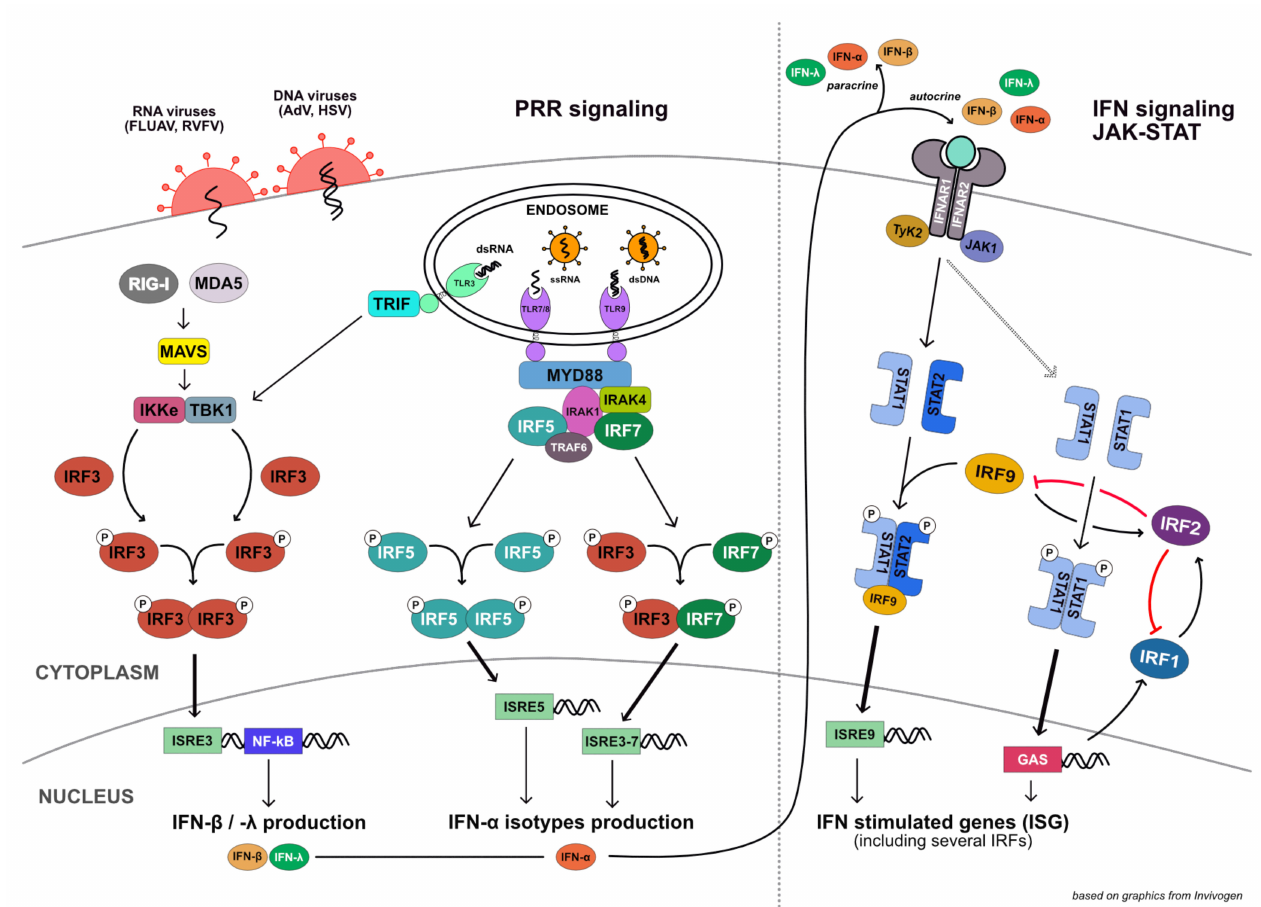
Figure 8. Schematic overview of the most prominent cell-intrinsic antiviral signaling pathways. The involvement of well-characterized IRF transcription factors is indicated, but does not reflect the actual complexity with various IRFs (e.g., IRF7, IRF1) only being expressed after initial stimulation of the pathway and ensuing positive transcriptional feedback. The figure is based on an illustration by Invivogen (https://www.invivogen.com/review-type1-ifn-production (accessed on 1 September